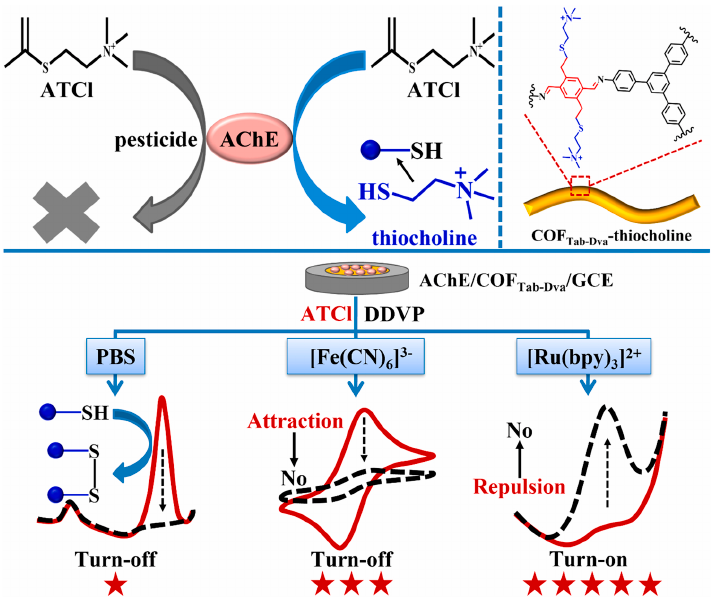
Figure 7. Schematic illustration of enzyme inhibition and DDVP determination from Ref. [90]. Copy right 2022 Elsevier.